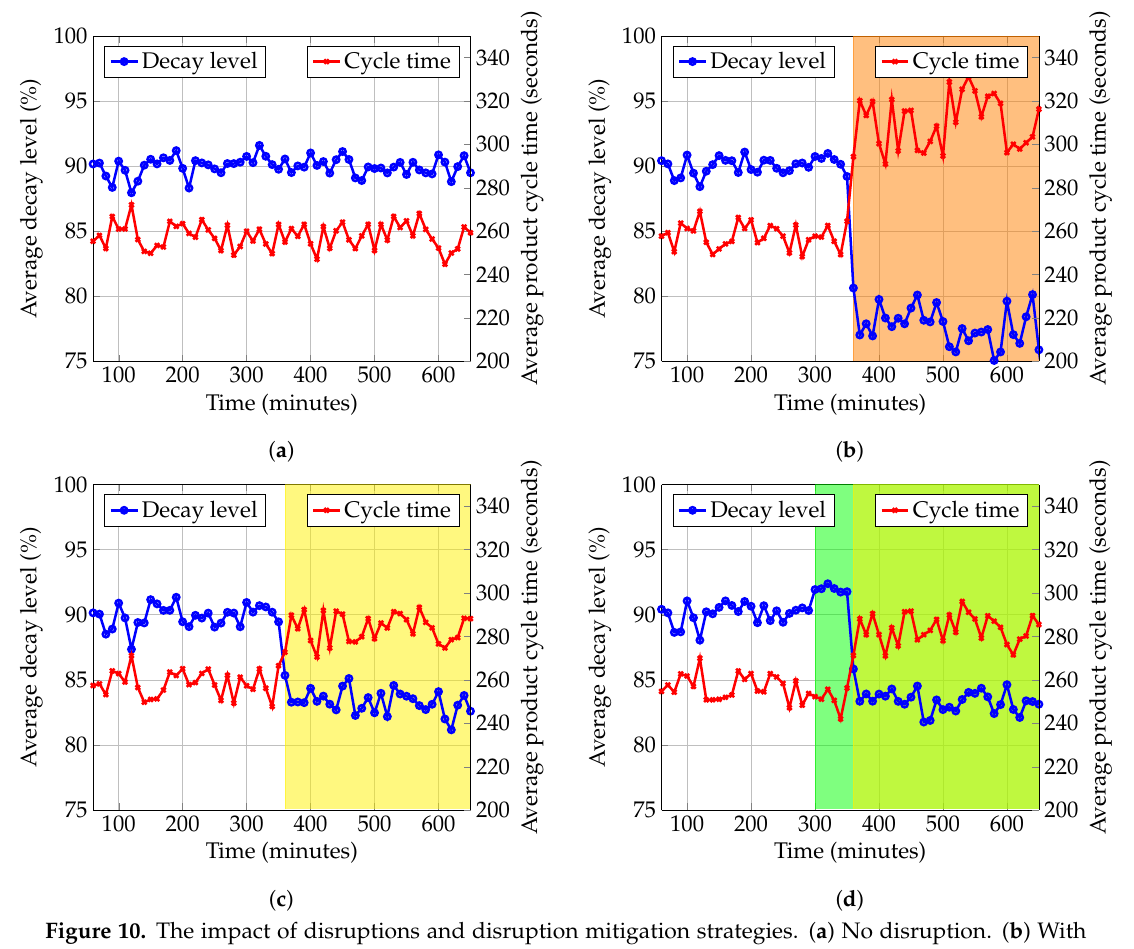
Figure 10. The impact of disruptions and disruption mitigation strategies. ( a ) No disruption. ( b ) With disruption after 6 h and a reactive mitigation strategy. ( c ) With disruption after 6 h and an unchanged strategy. ( d ) With disruption after 6 h and a proactive mitigation